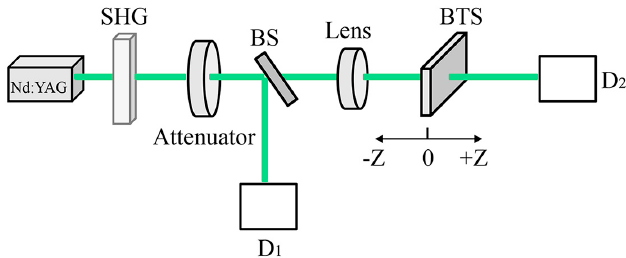
Figure 1. The schematic diagram of Z-scan technique.